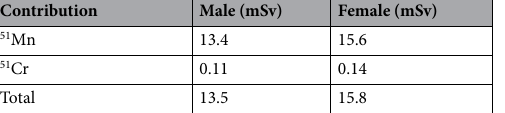
Table 3. Effective dose equivalent (EDE) for a 370 MBq intravenous injection of radionuclidically pure 51 Mn 2 + in the standard adult human male and